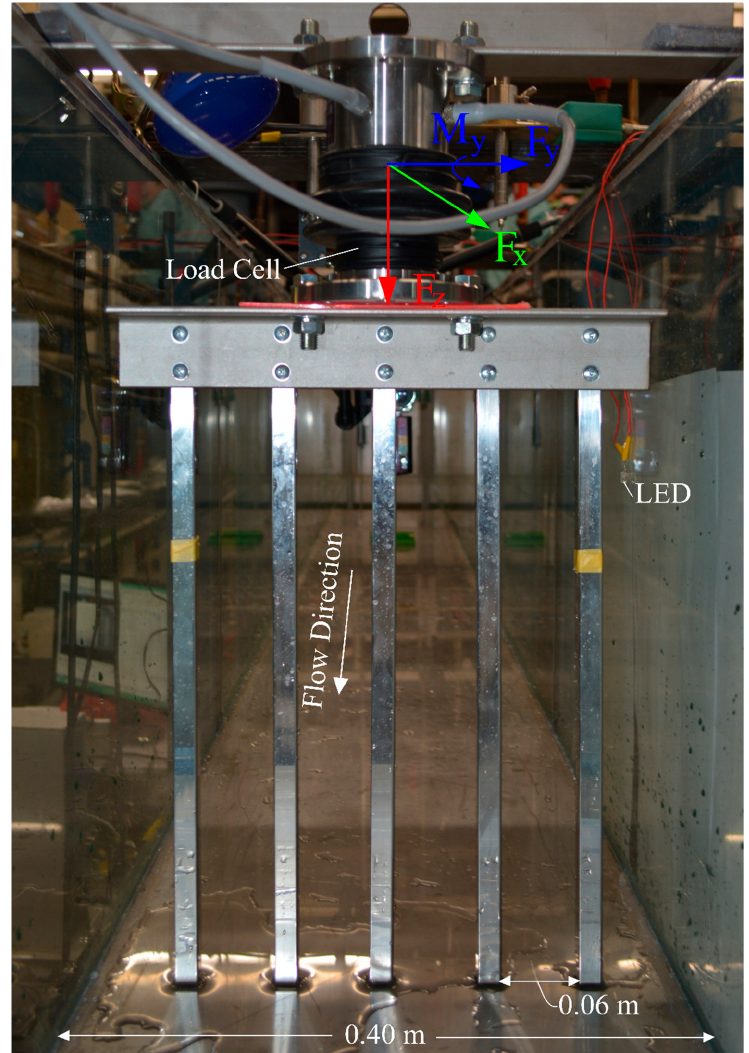
Figure 2. Downstream view of the obstacle setup.